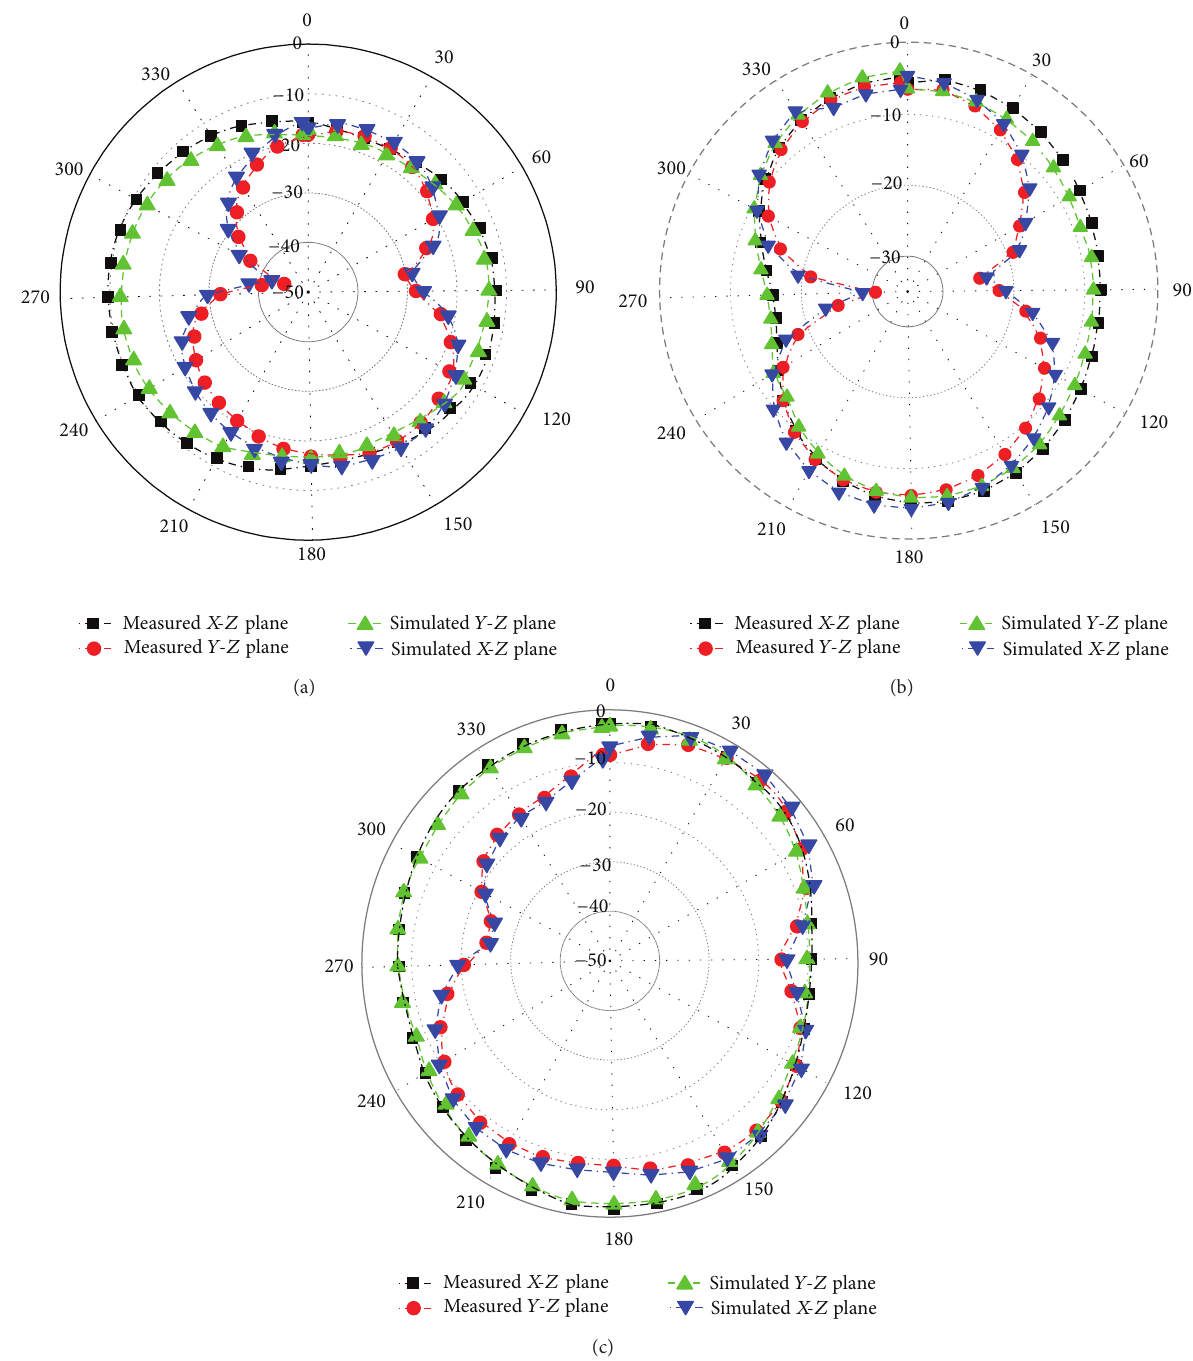
Figure 14: Radiation pattern of the proposed antenna at (a) 2.44 GHz, (b) 3.40 GHz, and (c) 5.98 GHz.